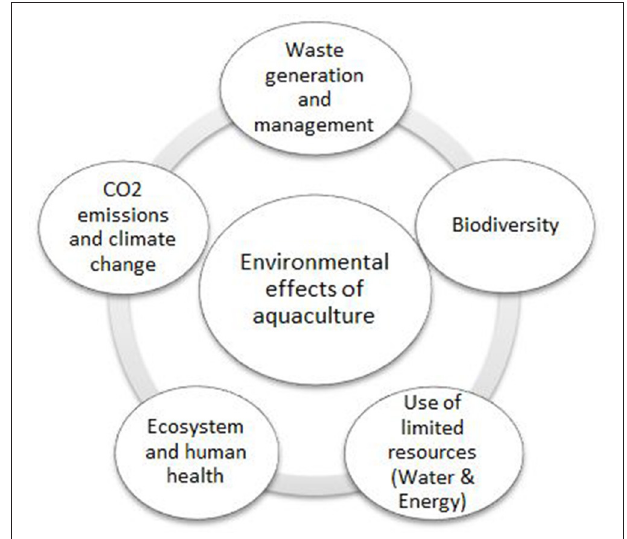
FIGURE 2 | Environmental effects of